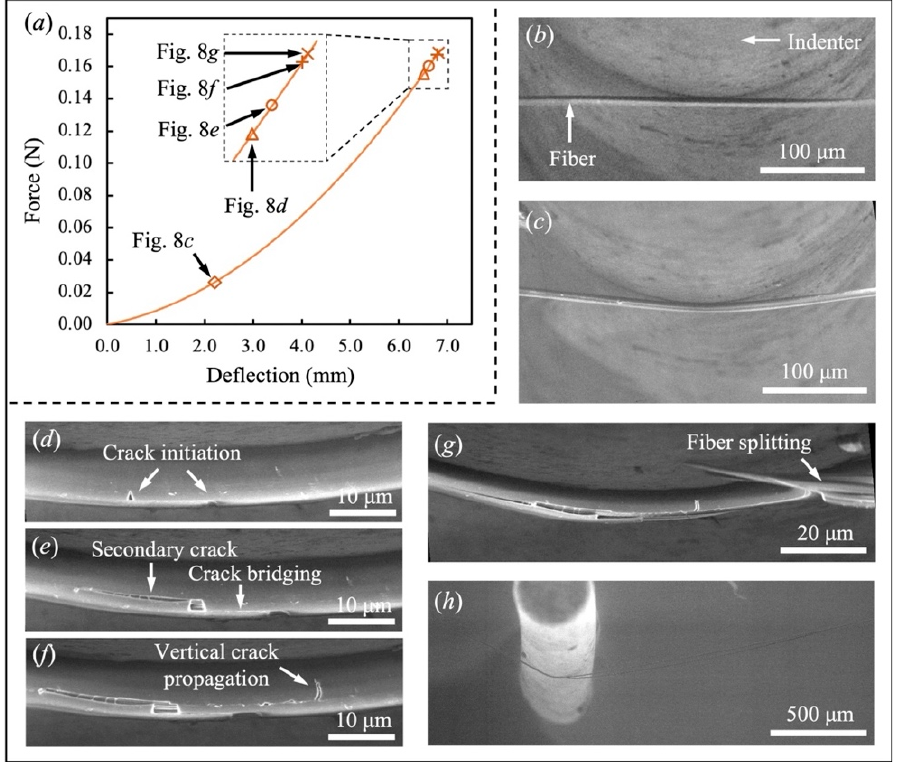
Figure 8. Failure behavior of a representative Kevlar KM2 Plus fiber. ( a ) Force-deflection curve; Real-time fiber morphology at S tr = ( b ) 0; ( c ) 2.206 mm; ( d ) 6.511 mm; ( e ) 6.621 mm; ( f ) 6.787 mm; ( g ) and ( h ) 6.817 mm.